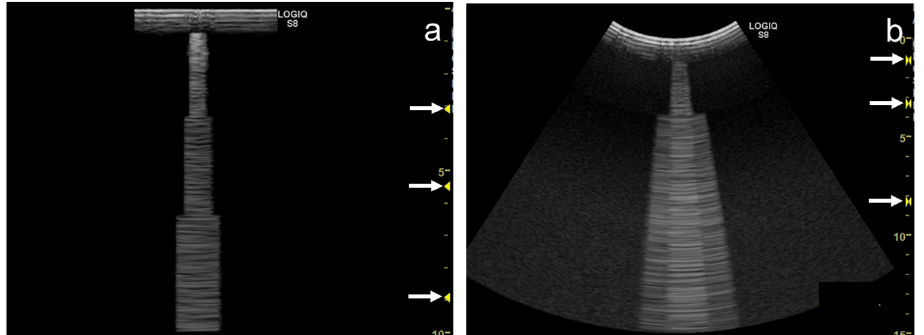
Figure 14. Ultrasound images obtained by a linear transducer ( a ) and a curvilinear transducer ( b )